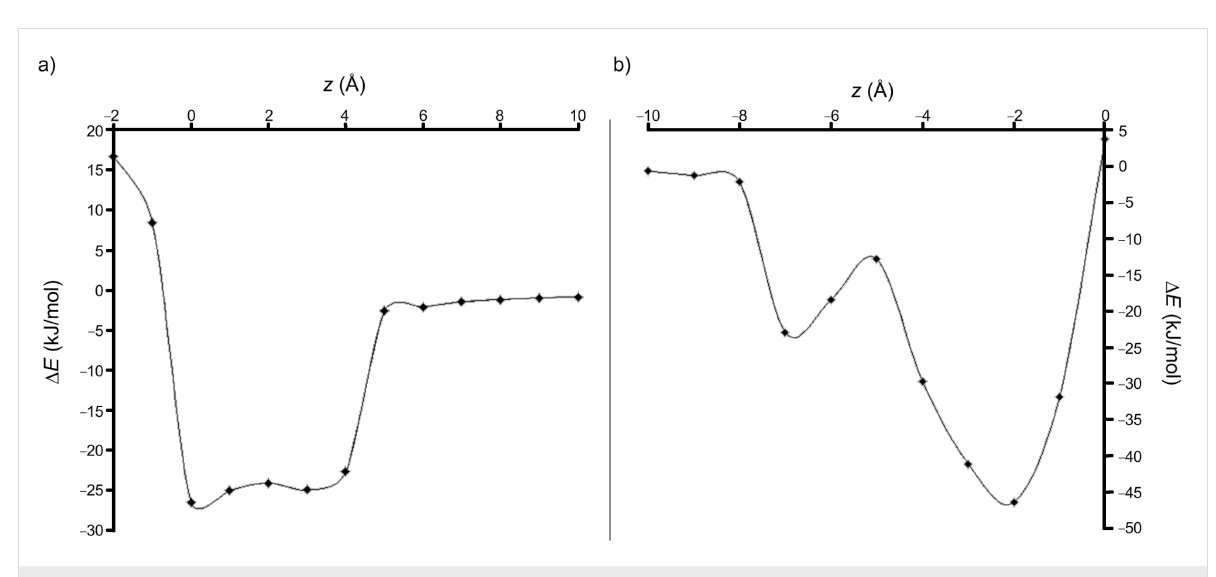
Figure 4: Evolution of the stabilization energy during the movement along the z axis in the case of (a) A and (b) B orientations of PP relative to the cavity of β -CD (PM3 calculation).